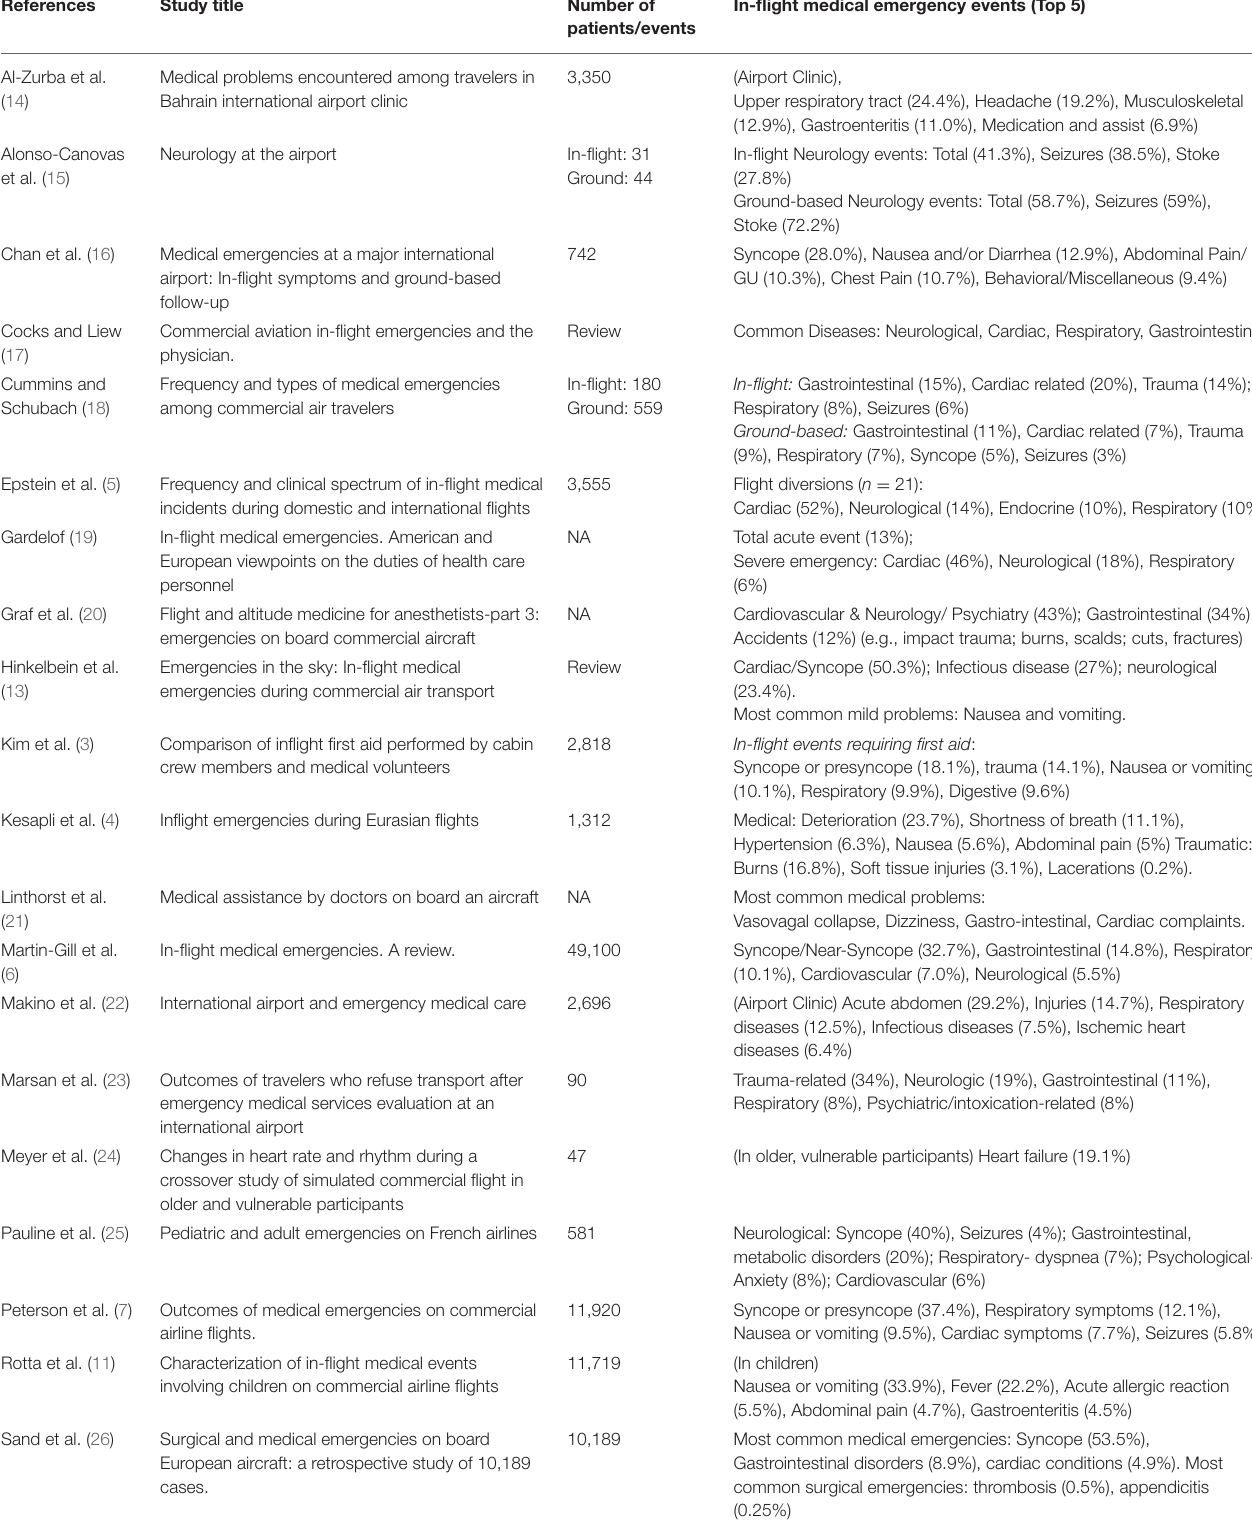
TABLE 4 | Summary of in-flight and ground-based emergency medical events reported in the